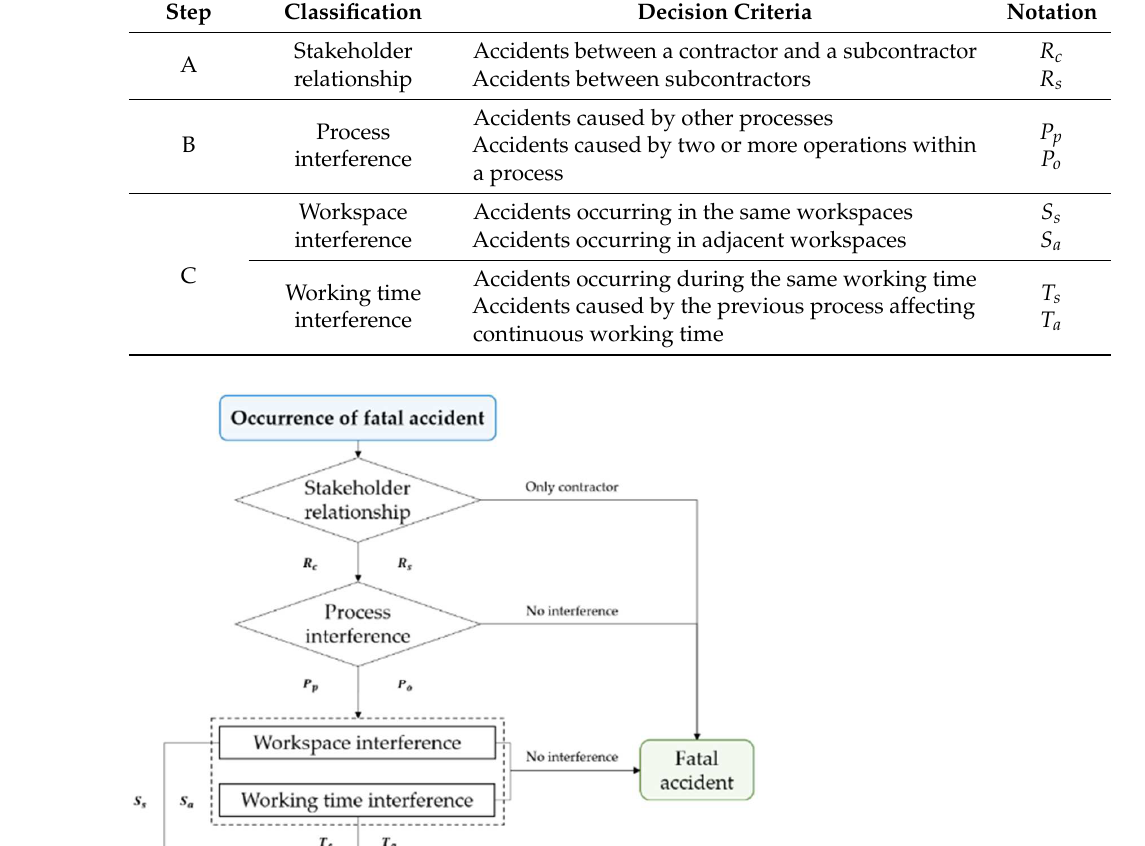
Table 2. Decision process criteria and notation of multiple processes in the workplace.